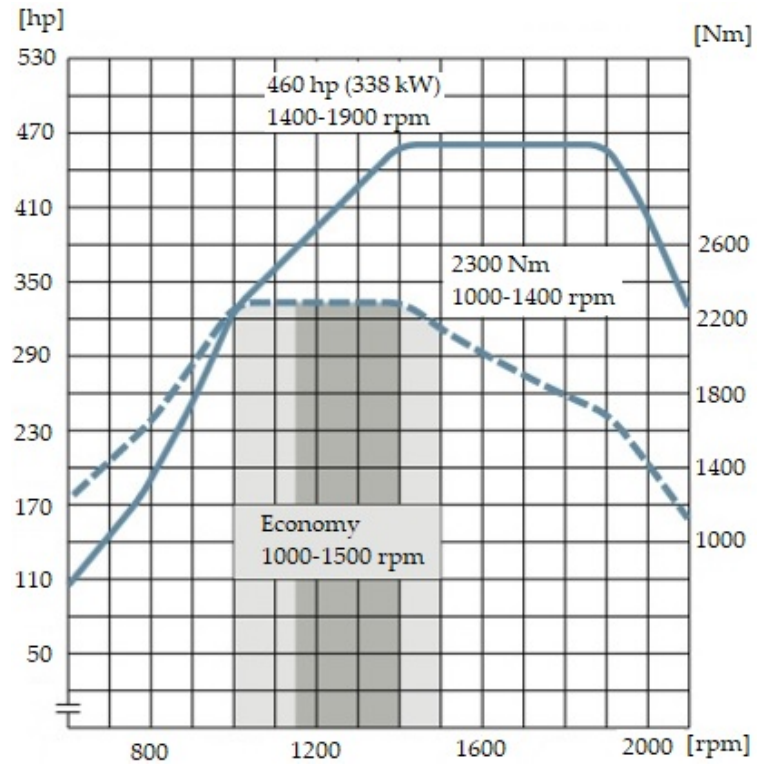
Figure 6. External characteristics of the tested engine [12] .